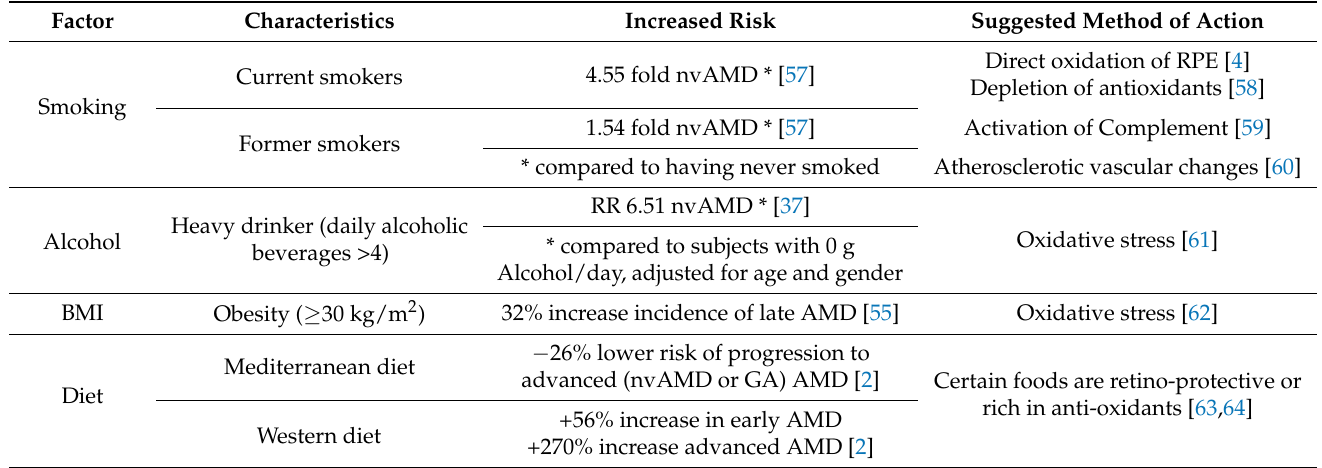
Table 3. Modifiable risk factors for